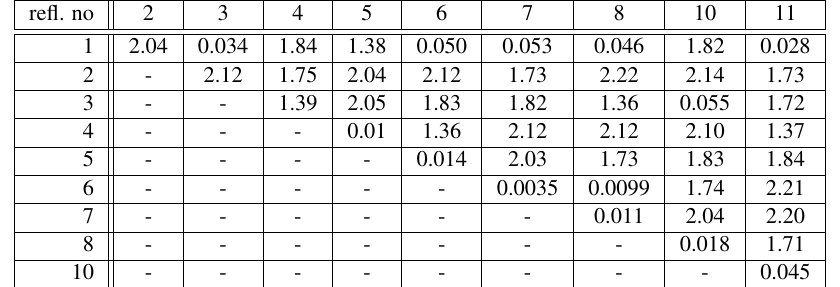
- - - - - 8 - - - - - - - - - Table 2: Values of σ 0 before 2 π ambiguity corrections. For σ 0 < 0 . 1 , no corrections were made, for σ 0 ≈ 1 . 4 , one correction was made, and for σ 0 ≈ 1 . 7 , two corrections were made. The remaining reflector pairs were not corrected. First, we created six triangles (or quadrangles) from the pairs with no corrections. In such triangles, the sums of the adjusted defor- mations (between the two reflectors in the pair) are also expected to be zero. However, for some triangles, this is not the case — it is close to ± 2 π . In these cases, one reflector pair must be selected and corrected by 2 π for the scene with inconsistent results;